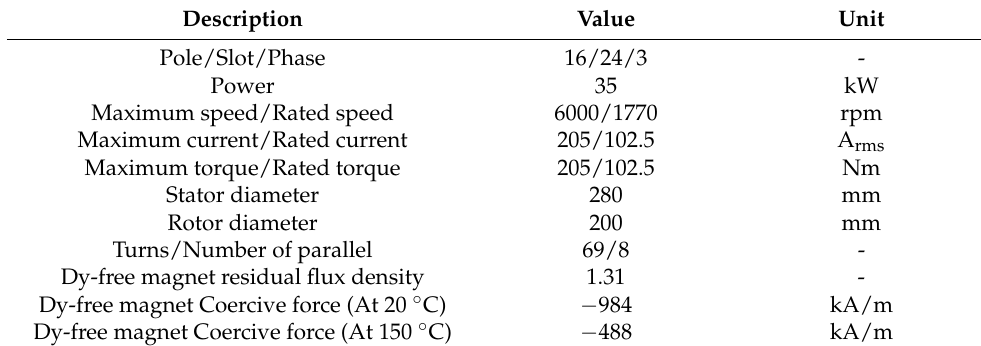
Figure 2. A rotor design process to reduce irreversible demagnetization and cogging torque: (a) rotor of conventional motor; (b) stator of conventional motor. Table 1. Specification of 35kW class hybrid traction motor with Dy-free magnet.